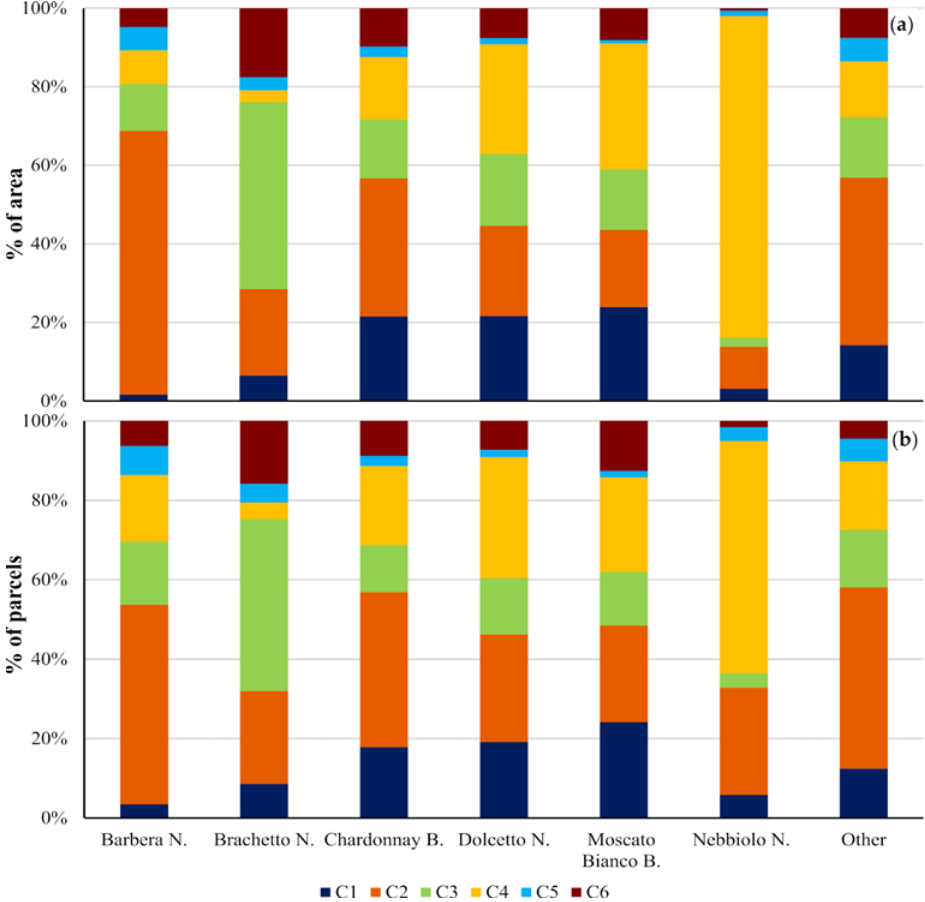
Figure 15. Analyzing grape variety dependence from zones (clusters): ( a )% distribution of clusters for grape variety (ha); and ( b )% of parcels cultivated with a specific grape variety per cluster . In the “Nebbiolo N.” vine variety, the C4 is strongly prevalent with a percentage of about 82% in terms of area (1056 ha) and 485 parcels (58.50% of total), suggesting a major specificity that this type of grape variety requires.